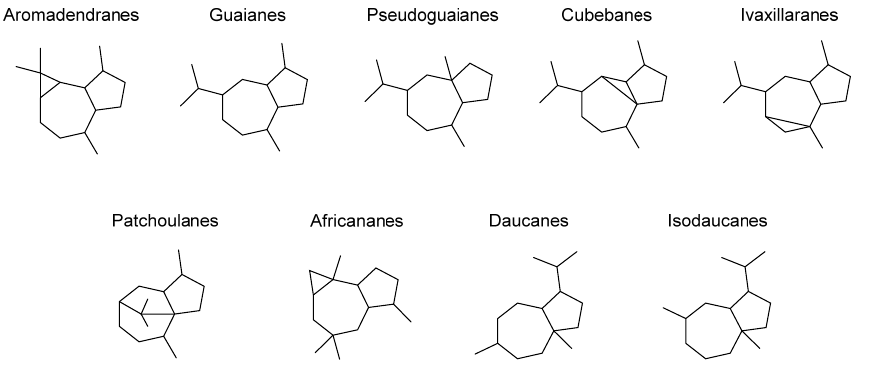
Figure 1. Sesquiterpenoid families containing hydroazulene core.